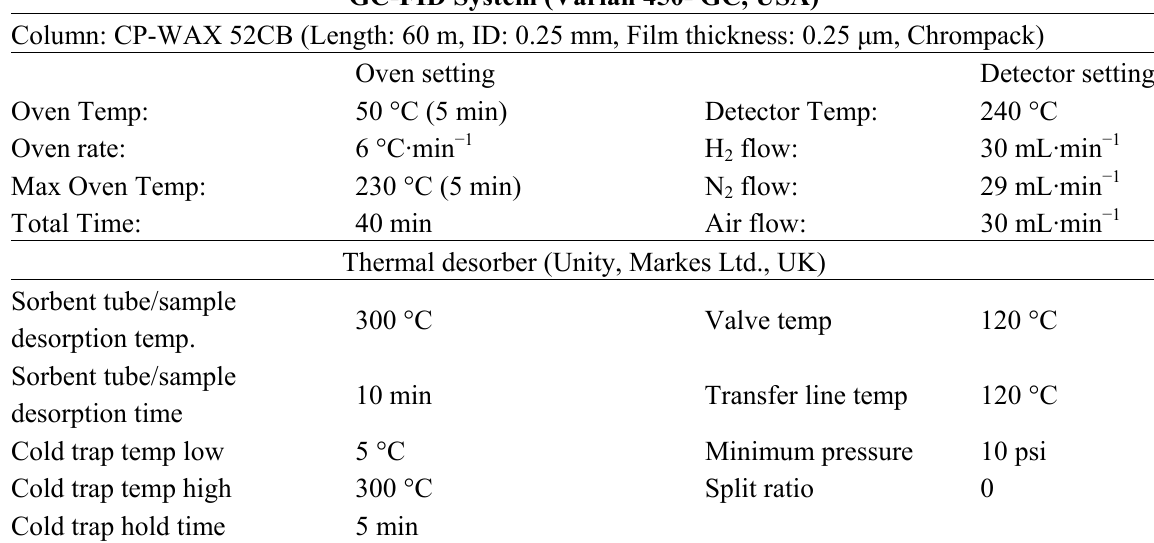
Table 2. TD and GC-FID settings for the analysis of PT-generated standards of BTEX by sorbent tube